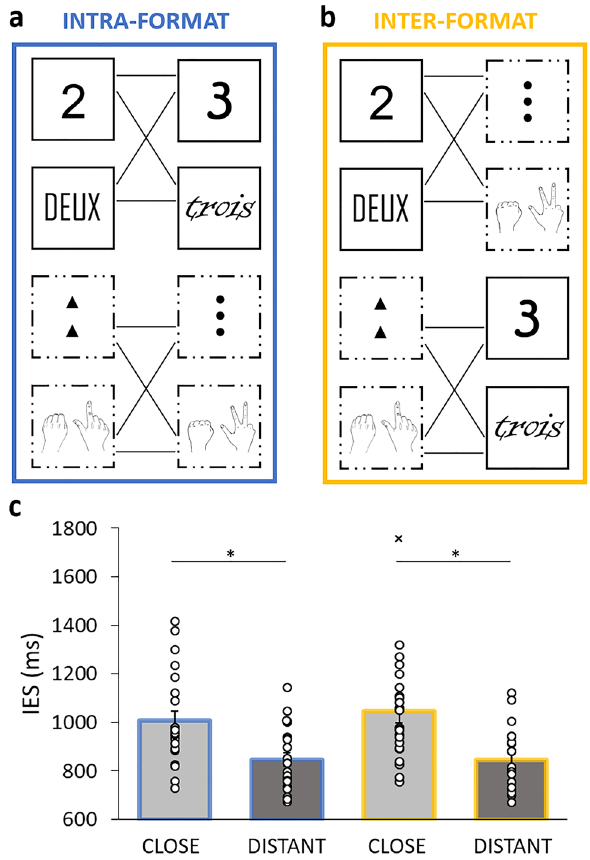
Figure 3. Example of pairs presented in the behavioral task. In intra-format presentations ( a ), pairs were both symbolic (i.e., digits or words) or iconic (i.e., dots or fingers); In inter-format presentations ( b ), symbolic format (i.e., digits or words) faced an iconic format (i.e., dots or fingers) and vice versa. ( c ) Participant’s mean IES in the close (light grey) and distant (dark grey) conditions, for the intra-format (blue) and inter-format (yellow) presentation types, which did not affect the distance effect. Dots show individual data and bars represent standard errors of the mean. Asterisks (*) highlight a significant difference between conditions with p < 0.01. The cross ( ˟ ) identifies the potential